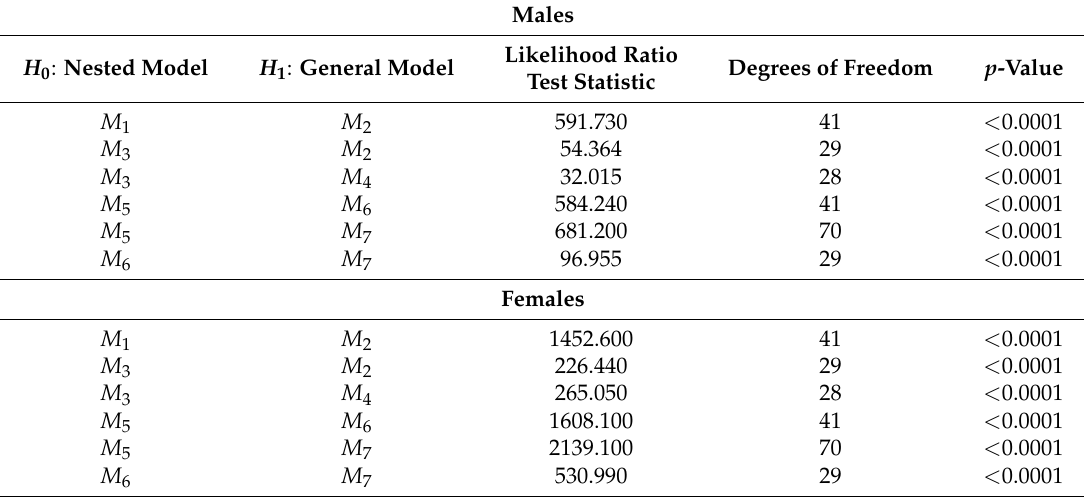
Table 3. Likelihood ratio test statistics for pairs of nested models ( H 0 ) within general models ( H 1 ). H 0 : Nested Model H 1 : General Model